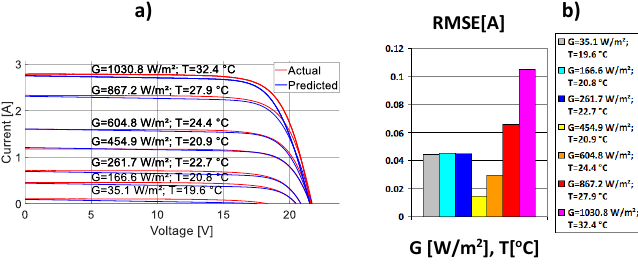
Figure 8. Comparison between the calculated (proposed model) and experimental curves of operation conditions of the multi-crystalline Cocoa mSi0166 PV panel: ( a ) Graphical comparison; ( b ) RMSE of proposed